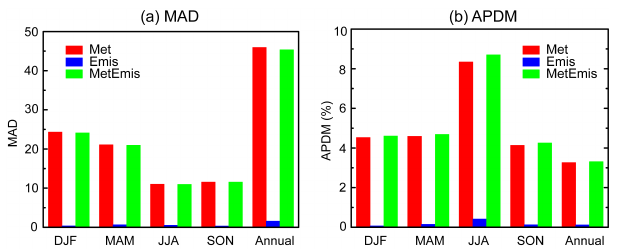
Figure 8. The MAD and APDM values of the detrended sea- sonal and annual O 3 outflow fluxes across the meridional plane along 135 ◦ E from 20 to 55 ◦ N and from the surface to 100hPa from 1986–2006 in the Met, Emis, and MetEmis simulations. Both MAD and APDM are defined in Sect. 4.2. The units of MAD are Tgseason − 1 for seasonal fluxes and Tgyr − 1 for annual fluxes.